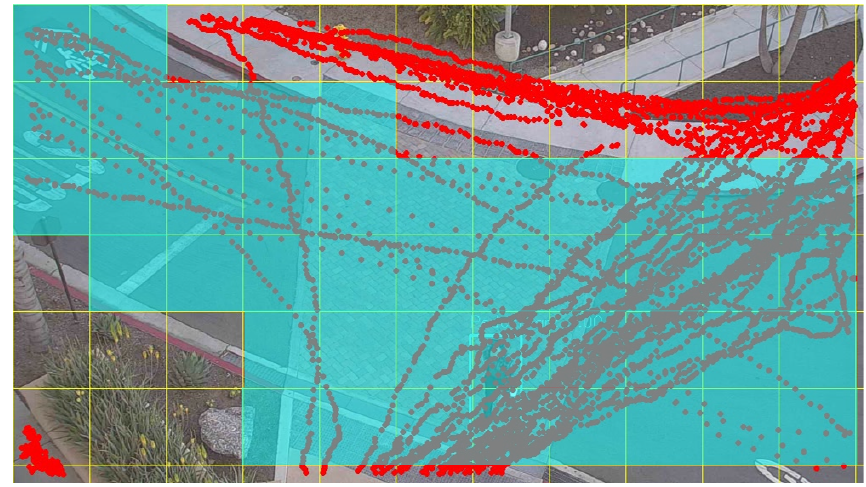
Figure 33. Selected Grids to be